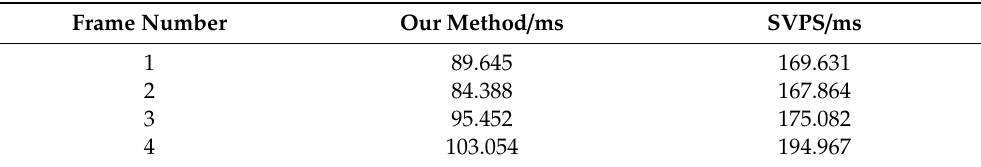
Table 5. Processing time of restoration algorithms.